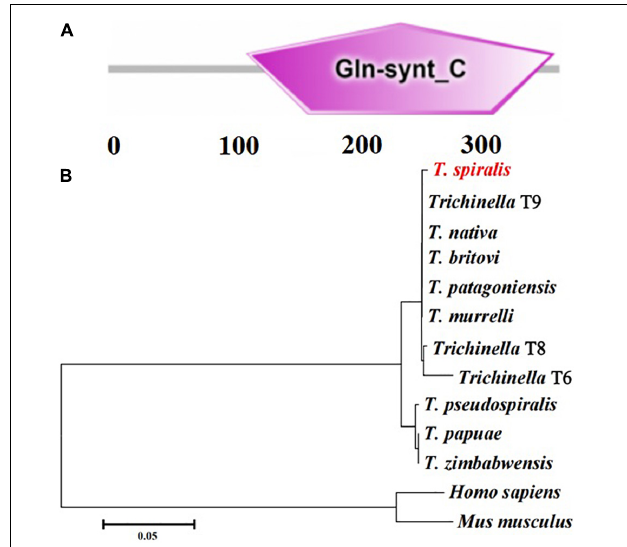
FIGURE 2 | The predicted TsGS catalytic domain (Gln-synt_C) (A) and phylogenetic trees of glutamine synthetase of 13 organisms with neighbor-joining method (B)